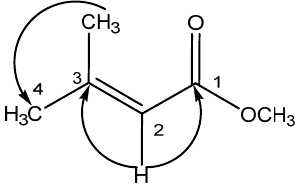
Figure 3. HMBC correlations (from H to C) of compound 3 .